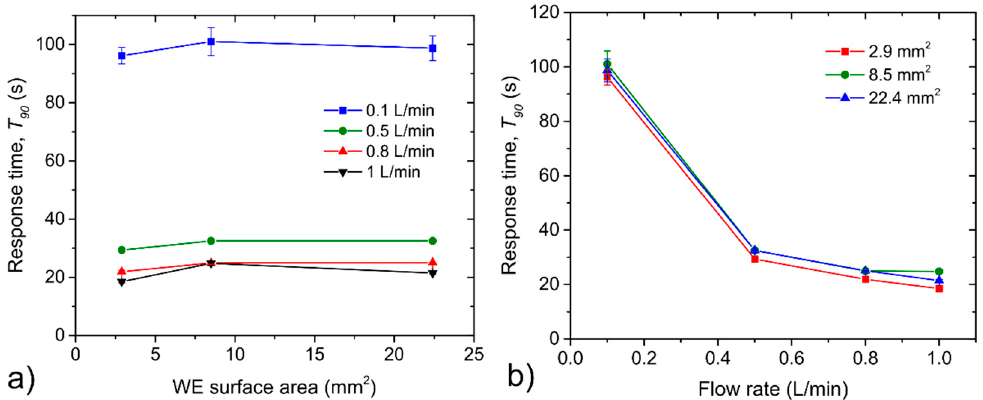
Figure 6. ( a ) Response time dependence on the WE surface area, ( b ) the response time dependence on the analyte flow rate. The error bars represent standard error of the mean that was calculated from three consecutive exposures to the same concentration.